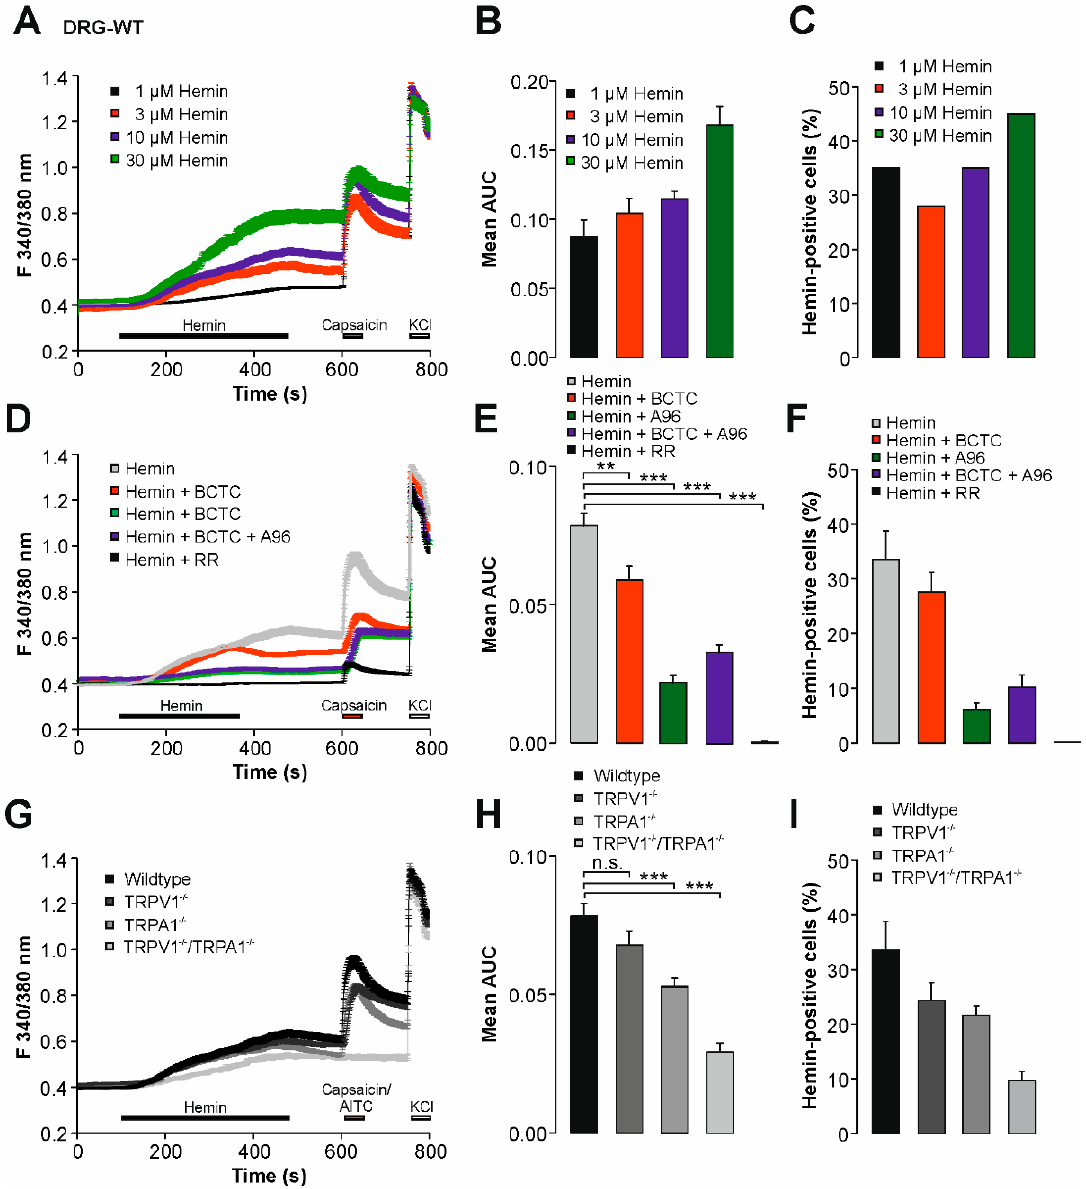
Figure 1. Hemin induces an increase in intracellular calcium in DRG neurons. ( A ) Concentration-dependent increase in intracellular calcium by hemin in wildtype DRG neurons. Hemin at 1, 3, 10, and 30 µ M was applied for 300 s followed by 1 µ M capsaicin for verification of TRPV1 expression and 40 mM KCl for identification of excitable cells. ( B ) Mean area under the curve (AUC) for hemin-induced calcium responses at different concentrations. ( C ) Mean percentages of hemin-sensitive DRG neurons at 1, 3, 10, and 30 µ M hemin. ( D ) Mean calcium influx on wildtype DRG neurons induced by 1 µ M hemin applied alone or in combination with BCTC, A967079, BCTC + A967079, or ruthenium red. Note that the combinations of hemin with inhibitors was only applied for 240 s, instead of 300 s for hemin applied alone ( E ) Mean area under the curve (AUC) for hemin-induced calcium responses in wildtype DRG neurons in presence of different inhibitors. The AUCs were calculated for 240 s application. ( F ) Mean percentages of hemin-sensitive DRG neurons at 10 µ M hemin applied alone or combination with different blockers. ( G ) Mean calcium influx induced by 10 µ M hemin in wildtype, TRPV1-knockout, TRPA1-knockout, or TRPV1/TRPA1-knockout DRG neurons. ( H ) Mean area under the curve (AUC) for hemin-induced calcium responses in DRG neurons of each genotype. ( I ) Mean percentages of hemin-sensitive DRG neurons derived from different genotypes, e.g., wildtype, TRPV1-knockout, TRPA1-knockout, and TRPV1/TRPA1-knockout. The AUCs were calculated for 240 s application. All data are shown as mean ± S.E.M. ** denotes p < 0.01, *** denotes p <